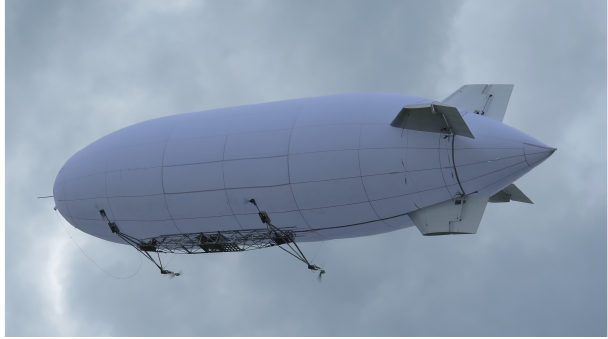
Figure 1. NOAMAY